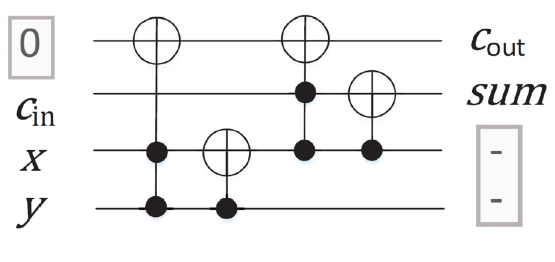
Figure 2. A reversible full added circuit with one constant input and two garbage